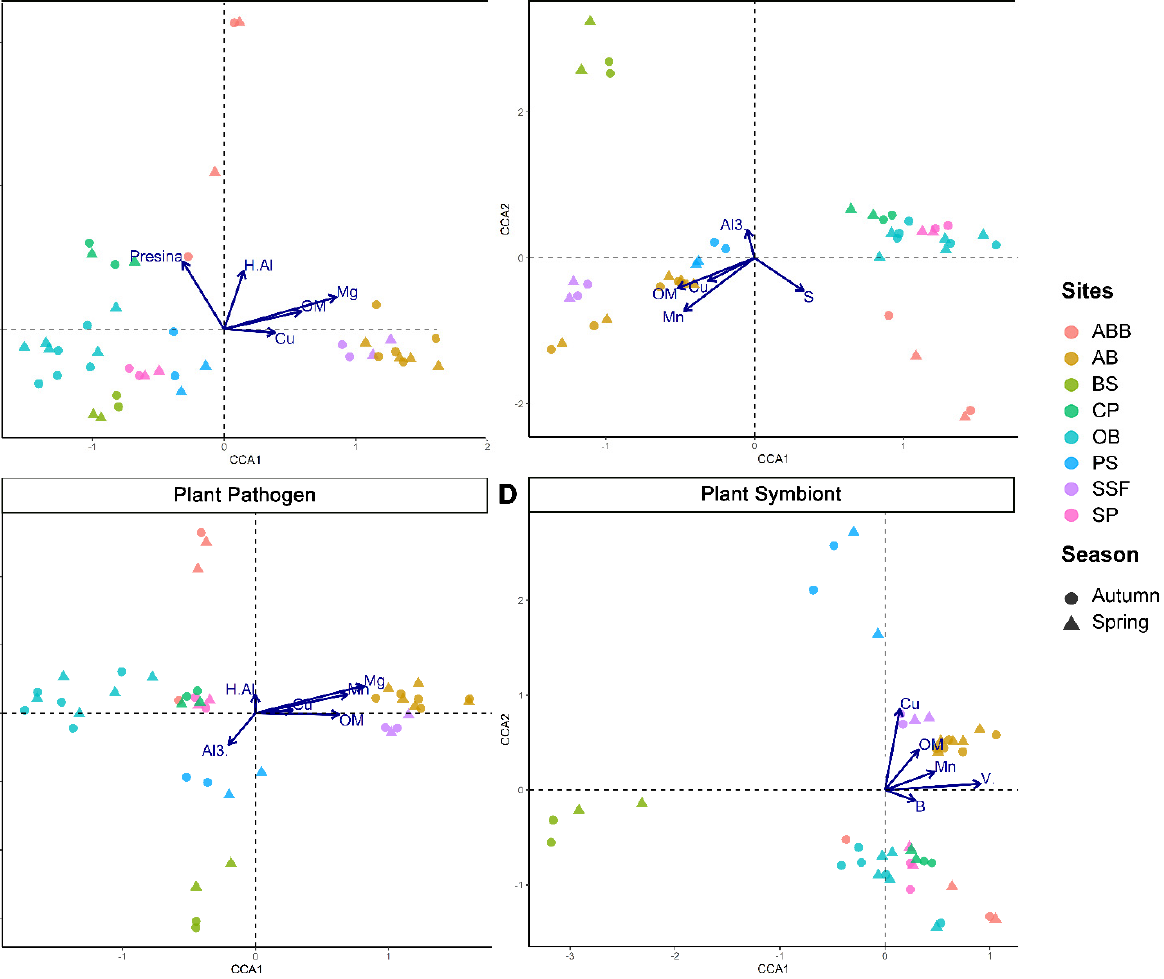
Figure 5. Canonical correspondence analysis (CCA) for guilds to verify the species–environment relationship separated by sample sites and correlations with environmental variables. Autumn = circle; spring = triangle; AB = armadillos’ burrows; BS = Brazilian savanna; CF = coffee plantation; OB = owls’ burrows; PS = pasture; SSF = seasonal semi-deciduous forest; SP = sugarcane plantation; OM = organic matter; Cu = copper; Mg = magnesium; Presina = resin phosphorus test; H.Al = potential acidity (H + Al); Al3. = aluminum cation; Mn = manganese; S = sulfur; V. = base saturation; B = boron. Guilds: ( A ) Animal Pathogen; ( B ) Saprotrophs; ( C ) Plant Pathogen; ( D ) Plant Symbiont .